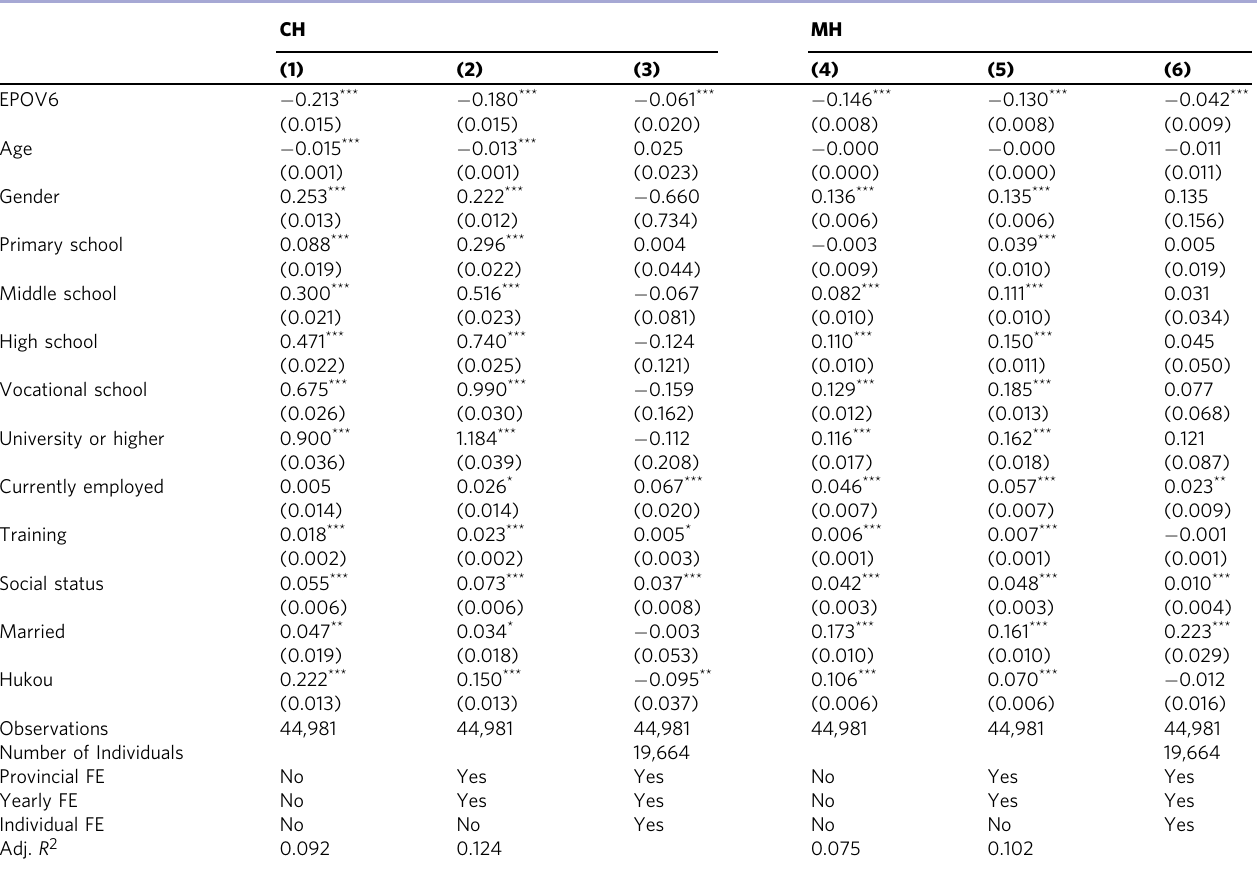
Table 3 Baseline